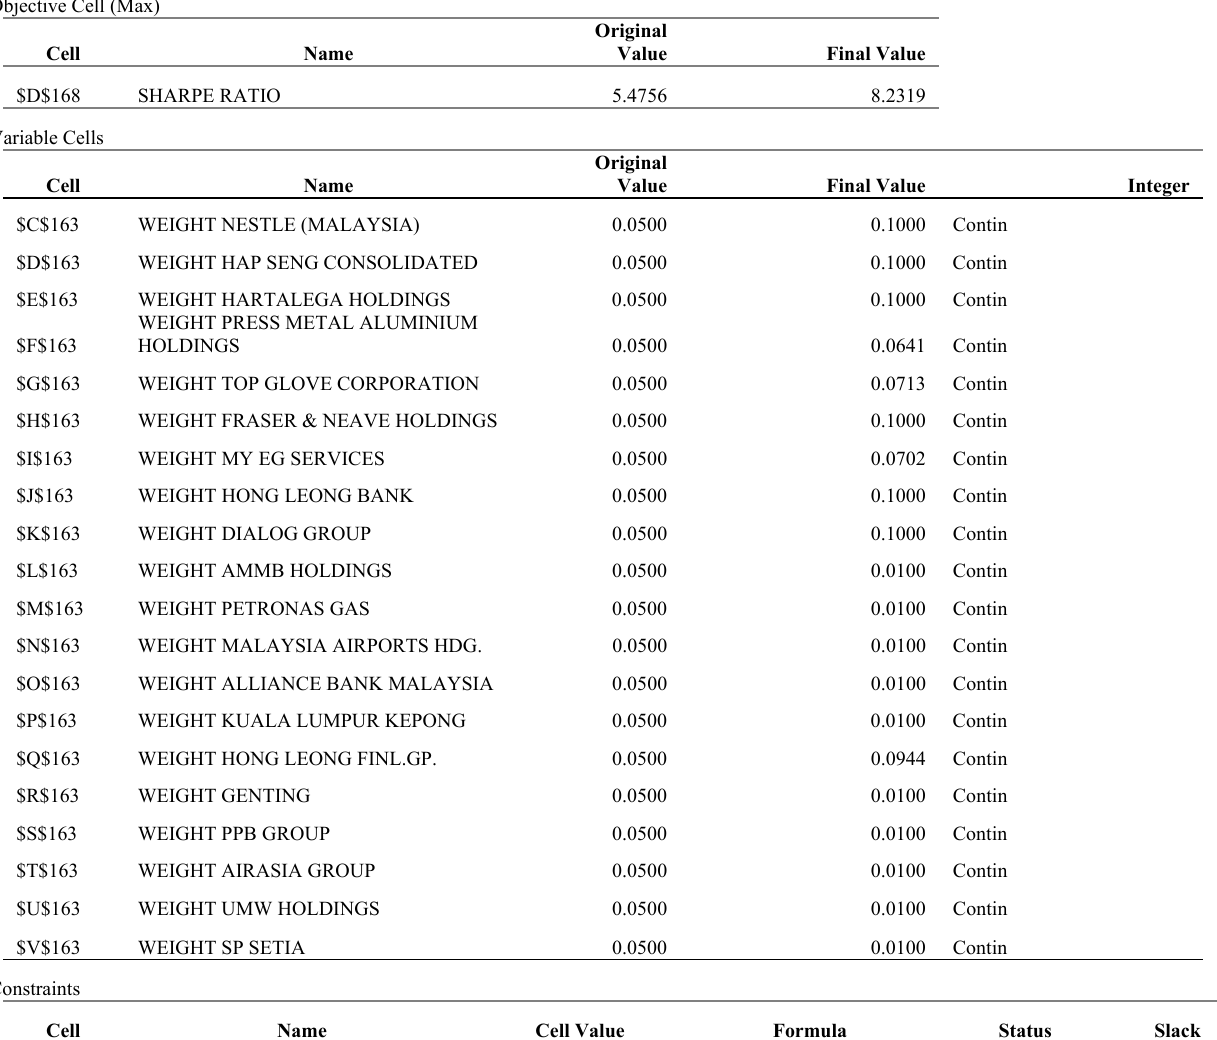
Table A9 Optimization report for Bottom Rating portfolio